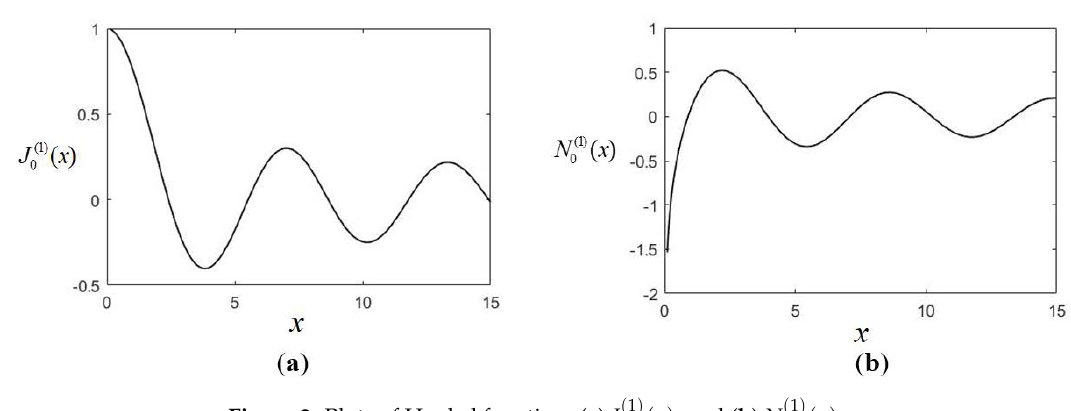
Figure 2. Plots of Hankel function: ( a ) J